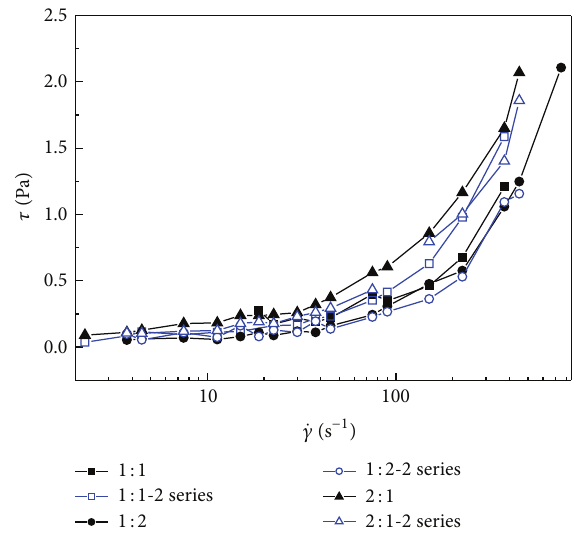
Figure 8: Shear stress versus shear rate flow curve of a fresh emulsion and of the emulsion after the application of the increasing shear rate in range 2.5–750 s −1